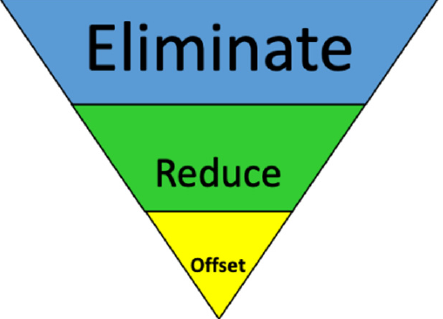
Figure 1. Adapted Hierarchy of Controls for Climate Change Mitigation.